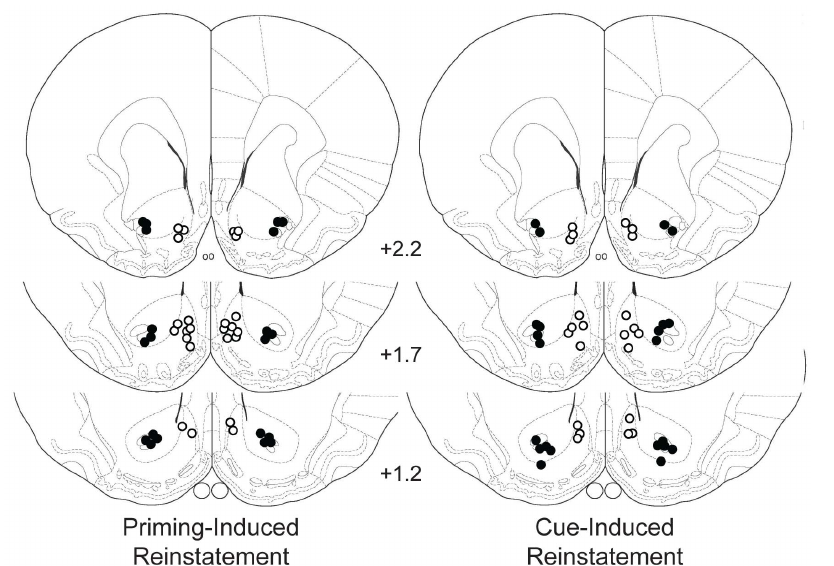
Figure 1. A schematic showing the placement of injector tips for animals included in the analysis following treatment of the NAcc shell (open circles) or core (filled circles) during priming-induced reinstatement (Experiments 1A&B, left panel) or cue-induced reinstatement (Experiments 2A&B, right panel). Numbers represent millimeters anterior to bregma. Drawings were adapted from The Rat Brain in Stereotaxic Coordinates, 4 th ed, G. Paxinos and C. Watson, Figures 10, 11, and 13, copyright 1998